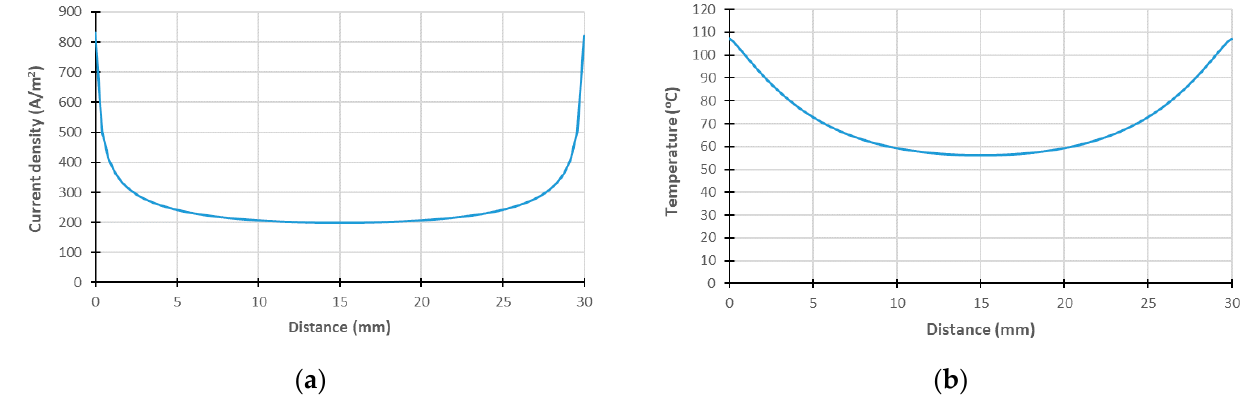
Figure 8. Results obtained along the vertical distance of the narrow part of the model for a volume conductivity of 1 mS/m and an external temperature of 20 °C with ( a ) the current density distribution and ( b ) the surface temperature distribution.